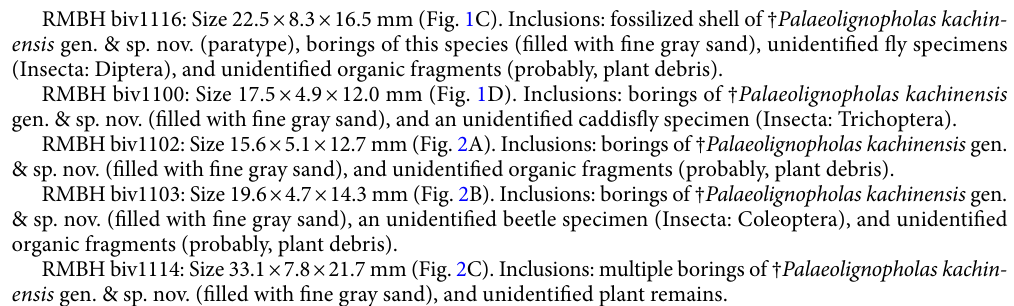
RMBH biv1114: Size 33.1 × 7.8 × 21.7 mm (Fig. 2C). Inclusions: multiple borings of † Palaeolignopholas kachin- ensis gen. & sp. nov. (filled with fine gray sand), and unidentified plant remains.